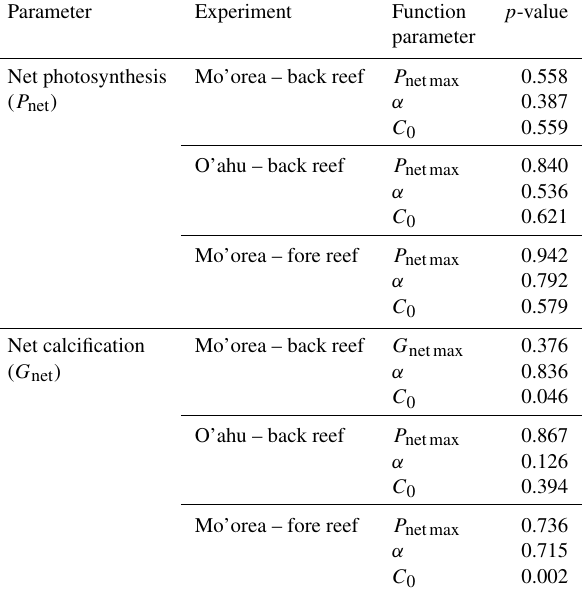
Table 2. Results of the t -tests used to compare between p CO 2 treat- ments the parameters of the hyperbolic tangent functions describ- ing the relationship between community net photosynthesis ( P net ) in the light and PAR and net calcification ( G net ) in the light and PAR. Parameters of the hyperbolic function are the maximum rate ( P netmax and G netmax ) , the slope of the initial portion of the rela- tionship ( α ), and the intercept ( C 0 ). Parameter Experiment Function p -value